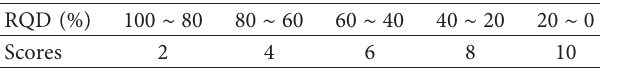
Table 2: The scores of the surrounding rock uniaxial compression